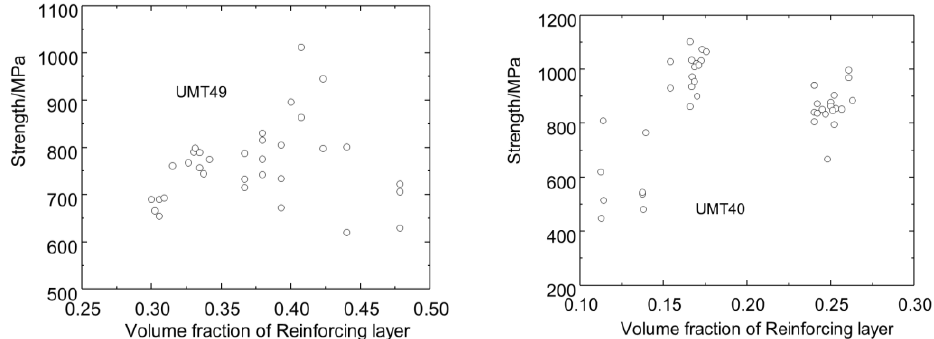
Figure 22. Strength versus the volume fraction of the reinforcing layer for the composites with UMT49 and UMT40 fibres.